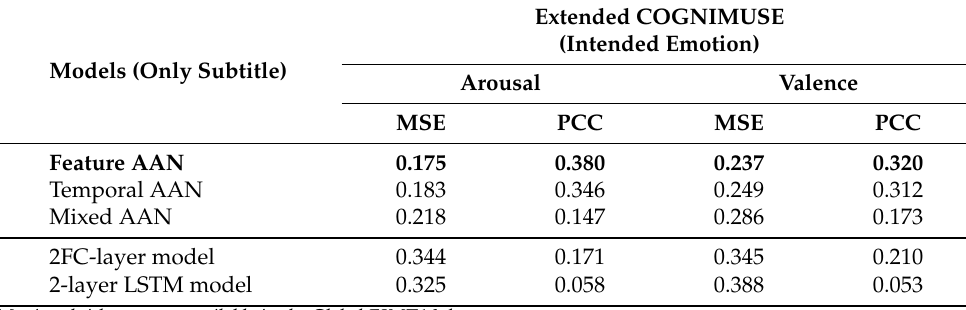
Table 3. The performance of the proposed models using only text features.